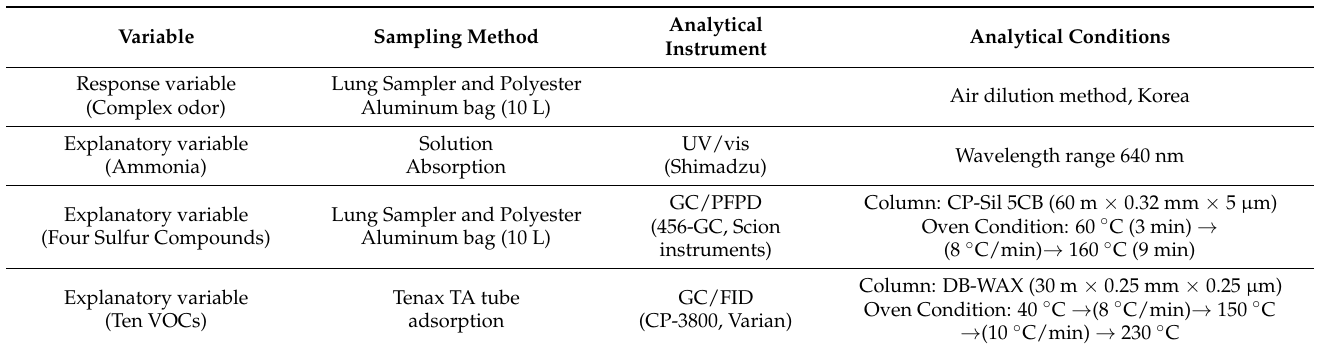
Table 1. Summary of the study’s various analytical